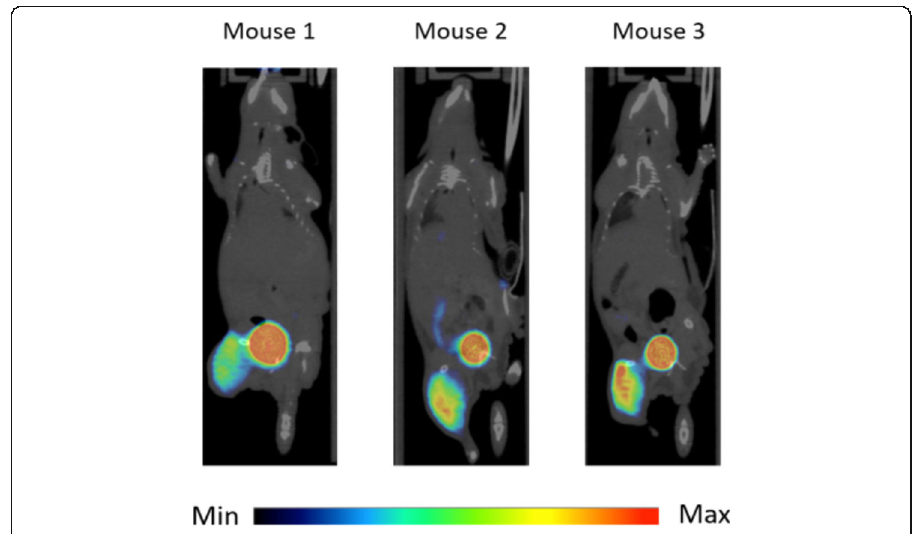
Fig. 7 In vivo evaluation of [ 68 Ga]Ga-DOTA.SA.FAPi uptake in a HT-29 xenograft mouse model.